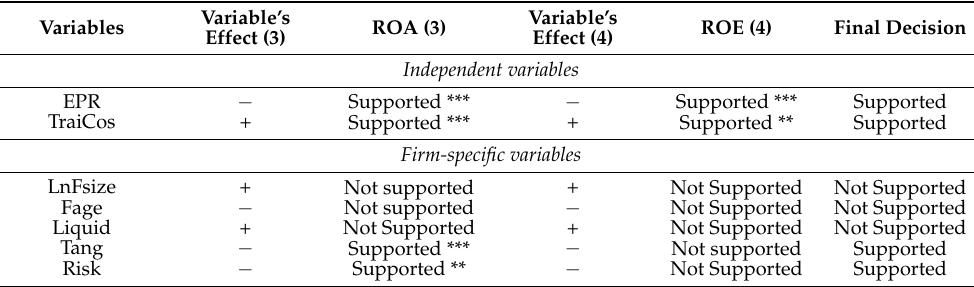
Table 9. Summary of hypothesis verification of model (3) and